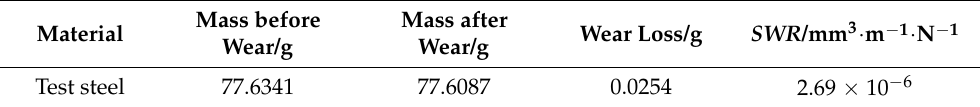
Table 4. Wear data and the SWR results of the test steel.